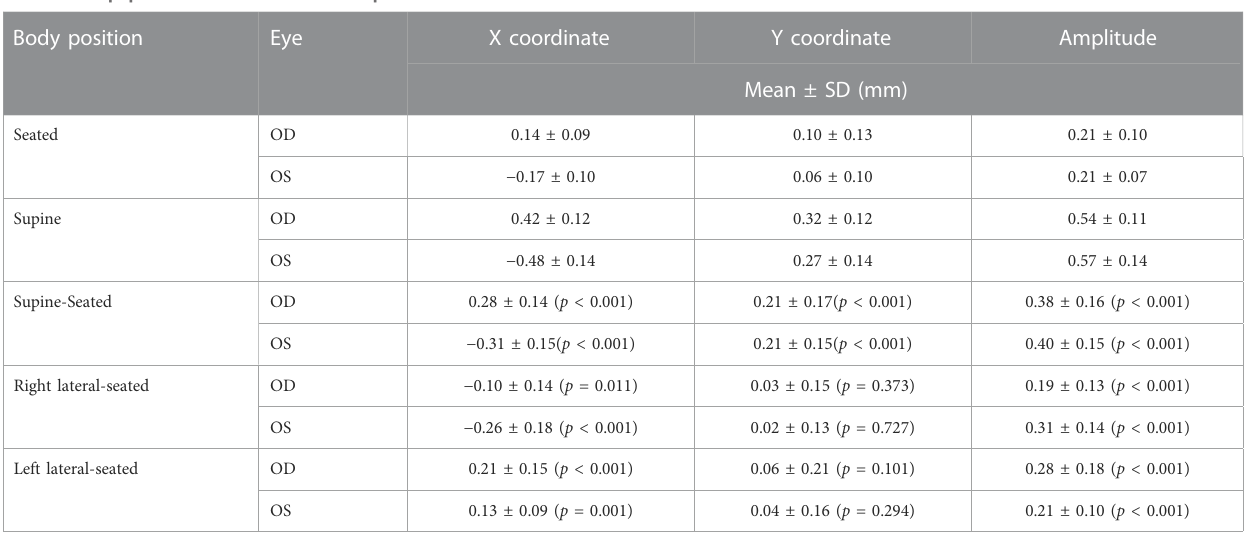
TABLE 2 The pupil center location at different